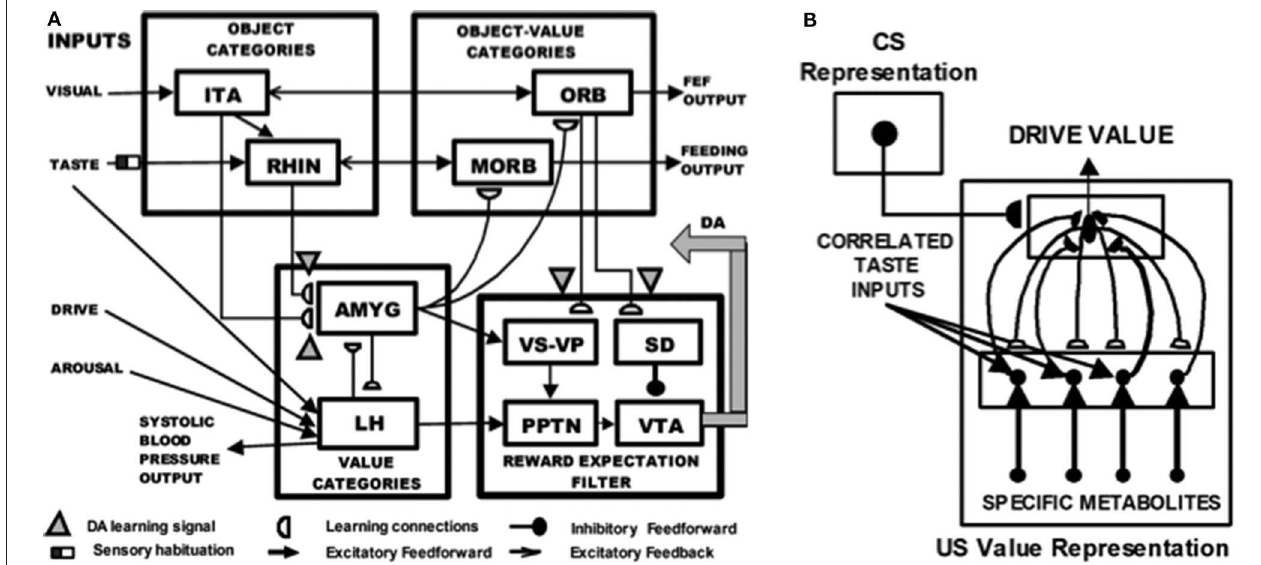
FIGURE 11 | (A) Object categories are activated by visual or gustatory inputs in anterior inferotemporal (ITA) and rhinal (RHIN) cortices, respectively. Value categories represent the value of anticipated outcomes on the basis of current hunger and satiety inputs in amygdala (AMYG) and lateral hypothalamus (LH). Object-value categories occur in the lateral orbitofrontal (ORB) cortex, for visual stimuli, and the medial orbitofrontal (MORB) cortex, for gustatory stimuli. They use the learned value of perceptual stimuli to choose the most valued stimulus in the current context. The reward expectation filter in the basal ganglia detects the omission or delivery of rewards using a circuit that spans ventral striatum (VS), ventral pallidum (VP), striosomal delay (SD) cells in the ventral striatum, the pedunculopontine nucleus (PPTN), and midbrain dopaminergic neurons of the substantia nigra pars compacta/ventral tegmental area (SNc/VTA). (B) Reciprocal excitatory signals from hypothalamic drive-taste cells to amygdala value category cells can drive the learning of a value category that selectively fires in response to a particular hypothalamic homeostatic activity pattern. See the text for details [adapted with permission from Dranias et al. (2008)].